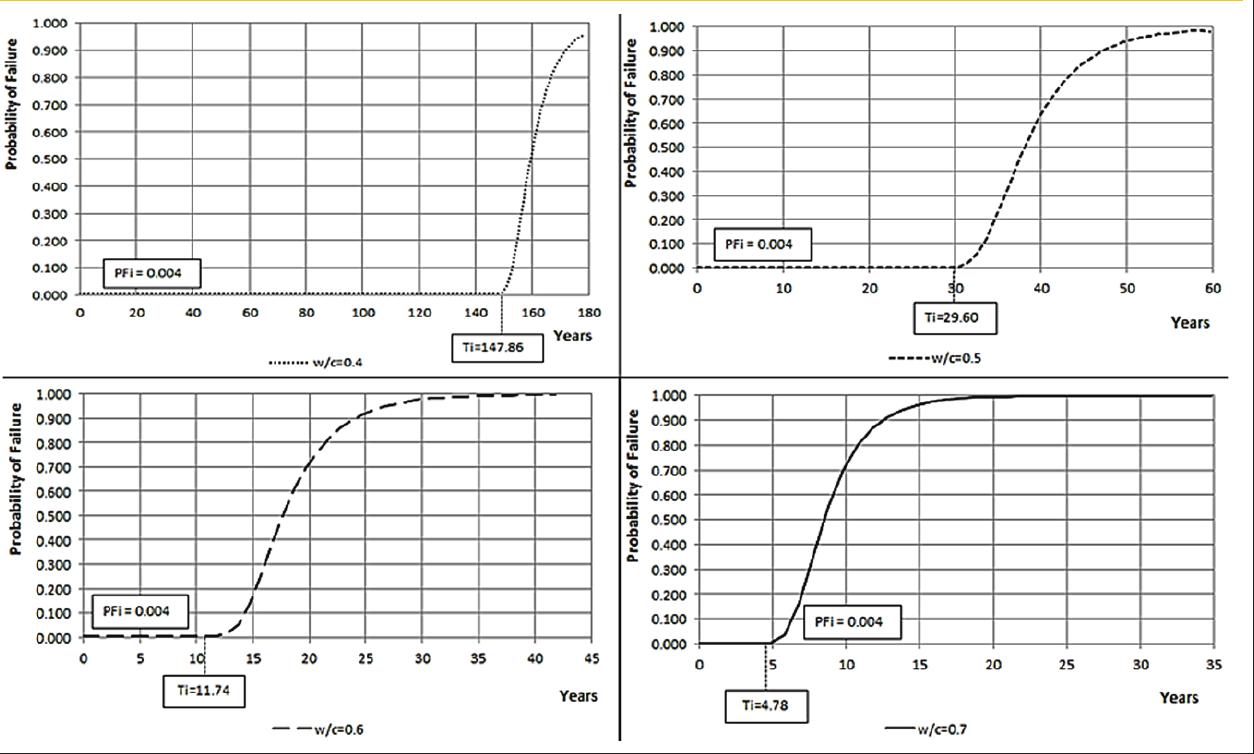
Figure 22 – Probability of failure along time for CA II and β x=0.628 double reinforcements'